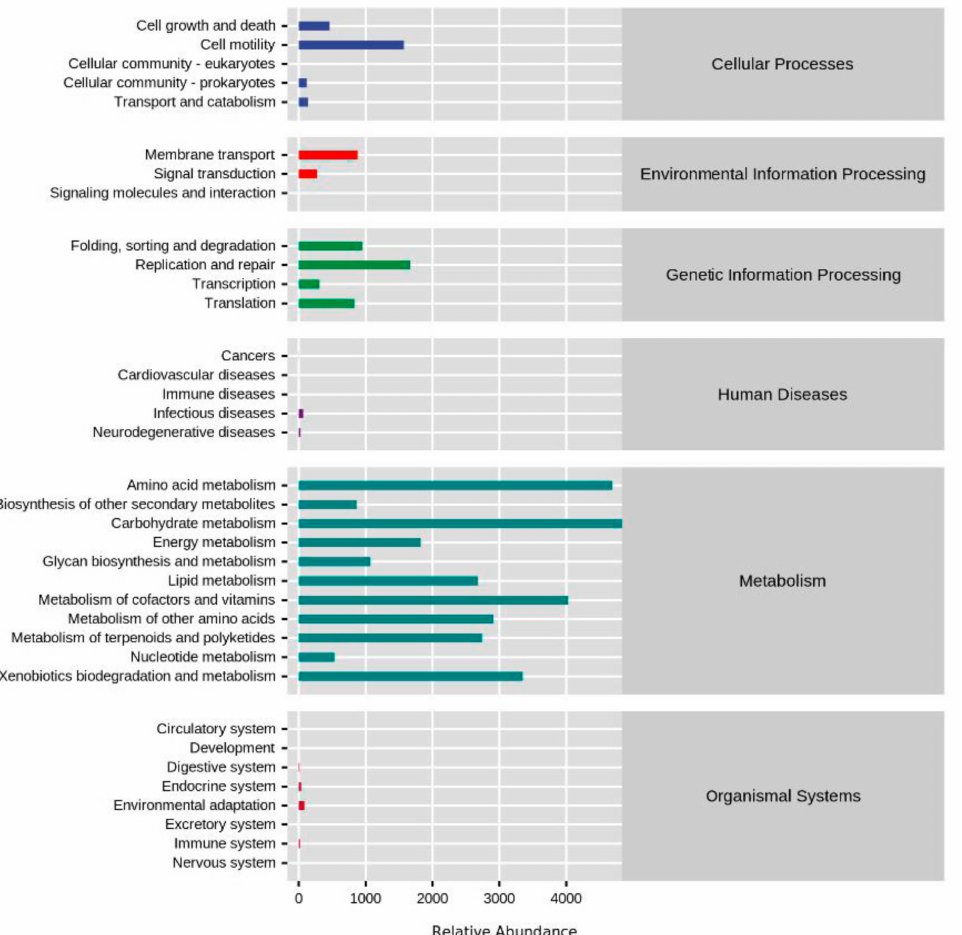
Figure 3. Functional profiles of the microbial community in the yolk. The abscissa is the abundance of the functional pathway, the ordinate is the functional classification of KEGG in the second level, and the rightmost is the first level of the pathway. Here is the average abundance of all selected samples or the count of all selected